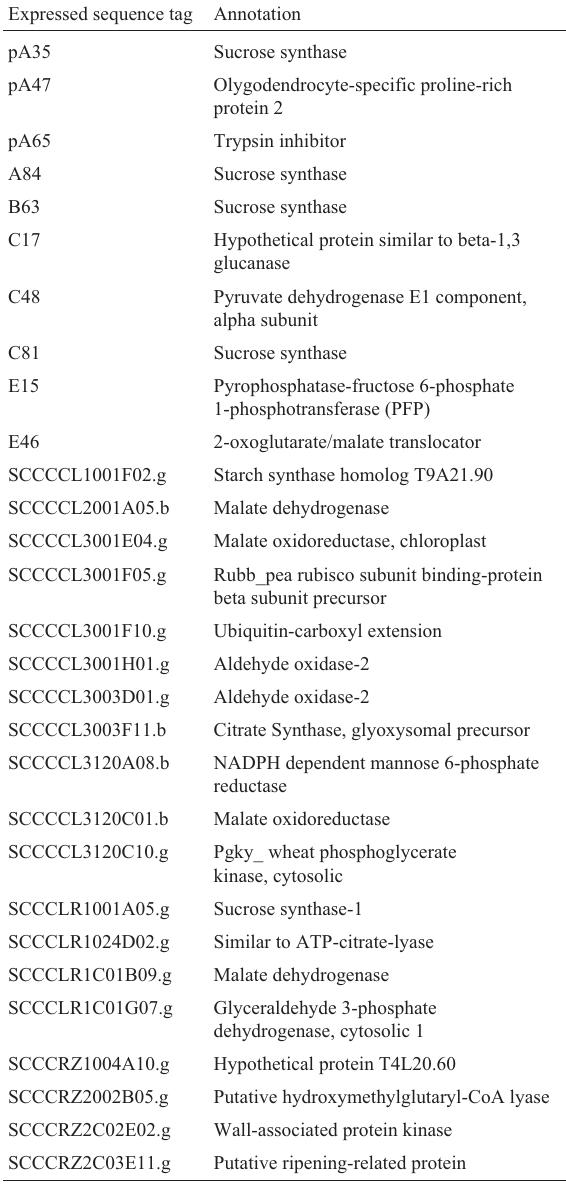
Table1 -ListofcDNAclones,representingexpressessequencetags,used as restriction fragment length polymorphism (RFLP) marker probes. Expressed sequence tag Annotation